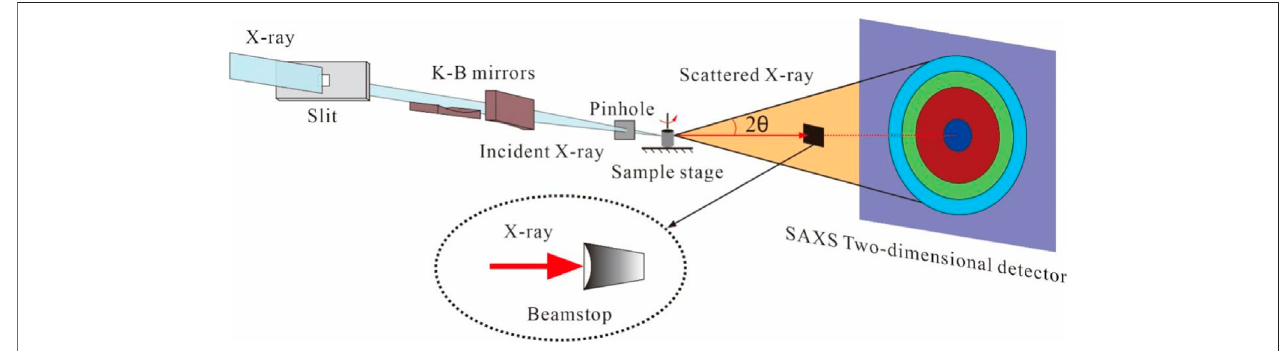
FIGURE 9 | Experimental principle of small angle X-ray